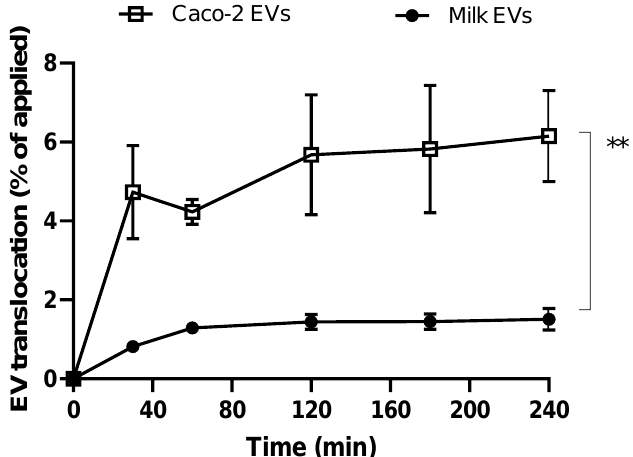
Figure 4. Translocation of milk-derived extracellular vesicles (EVs) and cell-derived EVs in differentiated/polarised Caco-2 cells. Data shown as the mean +/- SD ( n = 3). ** denotes p < 0.01